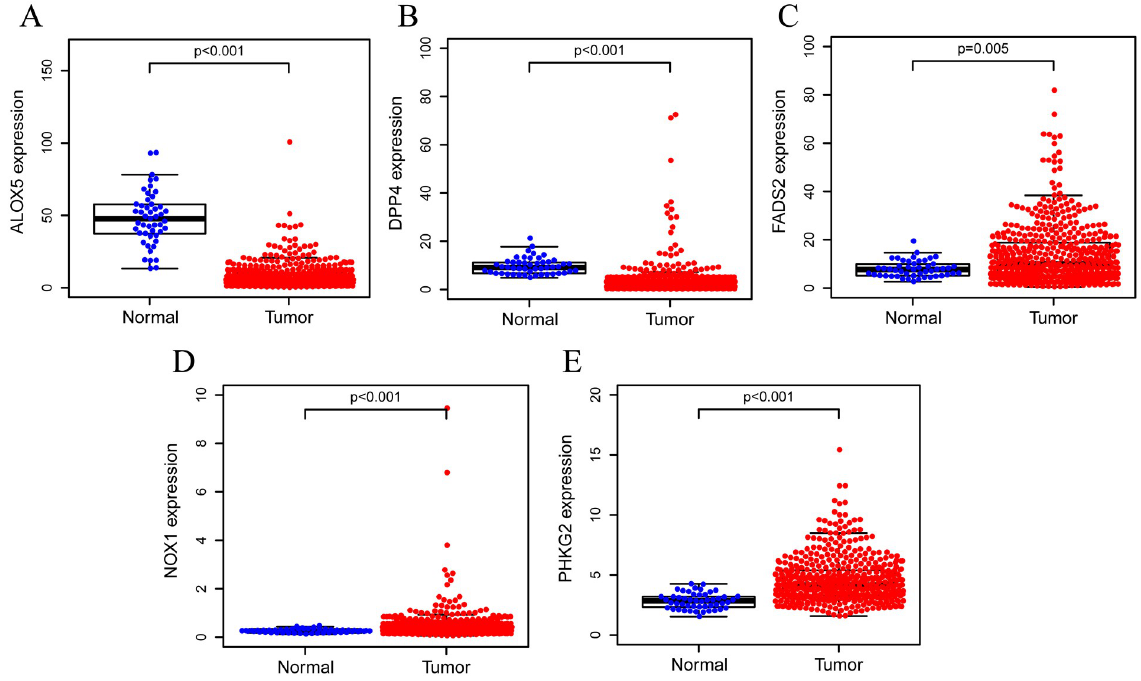
Fig 2. The expression of ALOX5(A) and DPP4(B) are significantly lower in LUSC tissues than in normal tissues and the expression of FADS2(C), NOX1(D), and PHKG2(E) are opposite in the TCGA cohort. (all adjusted P <